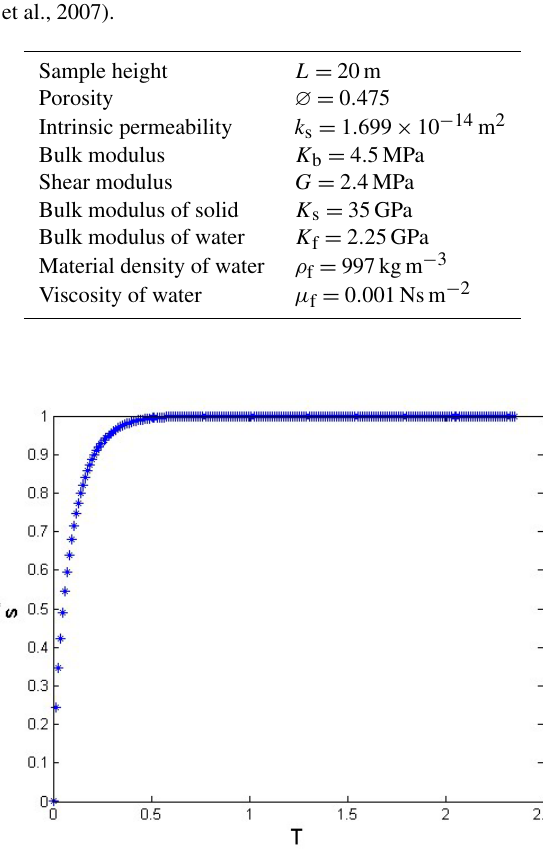
Table 1. Material parameters for saturated clay (Rawls et al., 1992; Lo et al., 2007).